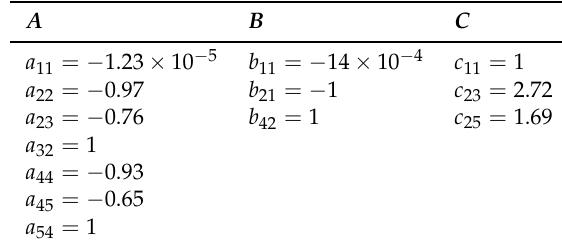
Table 1. System parameters of the state space formulation relevant to Equation (3).